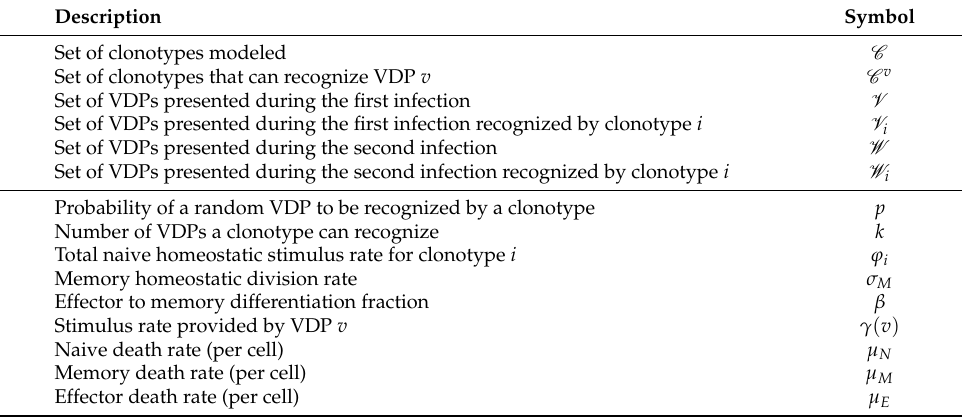
Table 1. Key sets and parameters used for the proposed model of the dynamics of T cells during a viral